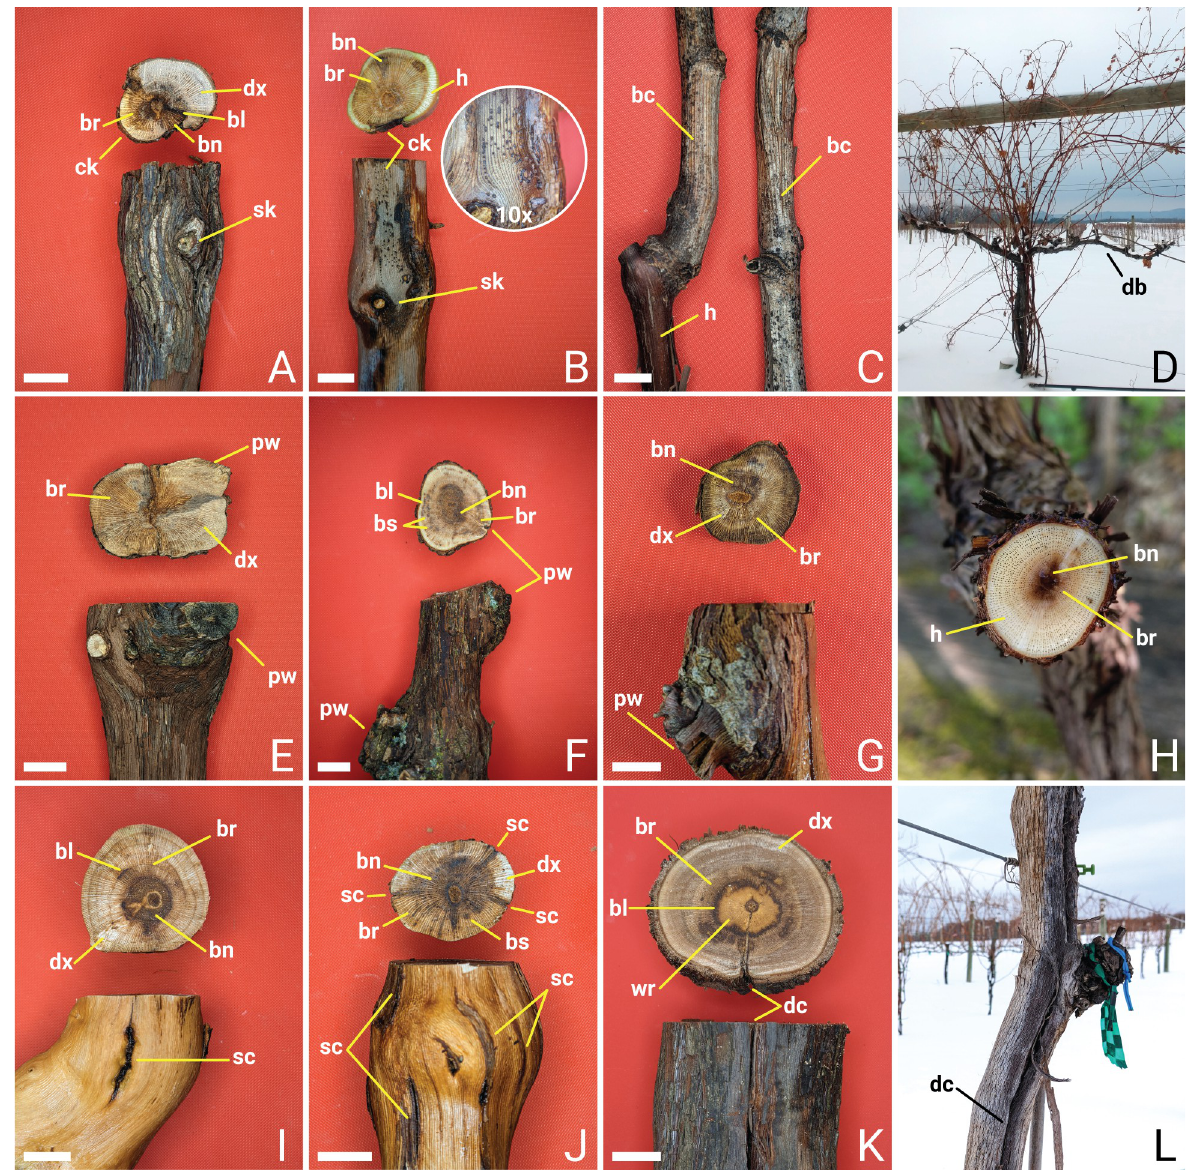
Fig 1. Symptoms of grapevine trunk diseases in Northern Midwest vineyards. Cankers were often associated with skips in the cordons but had rarely wedge-shaped discoloration (A). Cankers more often had irregular shaped xylem reactions (B). Pycnidia were sometimes observed fruiting from cankers (B) and bleached canes (C). Dieback symptoms are common and the result of successive skips starting from tips of cordons (D). Pruning wounds were associated with minor (E), moderate (F), and severe (G) vascular streaking symptoms. Near completely healthy vascular tissue observed in wild Vitis riparia vines (H). Infrequent shallow cracks (I), several shallow cracks (J), and deep cracks (K and L) were associated with minor to moderate (I), moderate to severe (J), and severe (K) vascular symptoms. Winter injury often results in deep cracks on the trunk (L). Observations included cankers (ck), skips in the cordons (sk), bleached canes (bc), dieback (db), pruning wounds (pw), shallow cracks (sc), deep cracks (dc), black spotting (bs), black lines (bl), brown-red wood streaking (br), brown to black necrotic streaking (bn), discolored xylem (dx), sometimes healthy tissue (h), and white rot (wr). Bars = 1